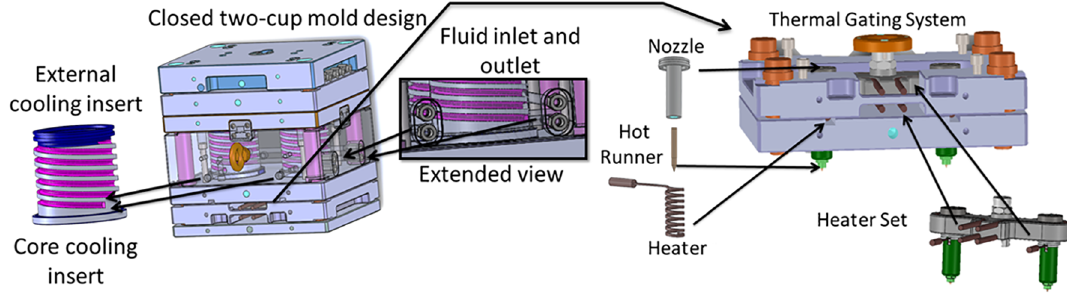
Figure 4. Cooling system and gating design. Table 2. Values of the processing parameters used in the experimental and simulation tests. Variable Processing